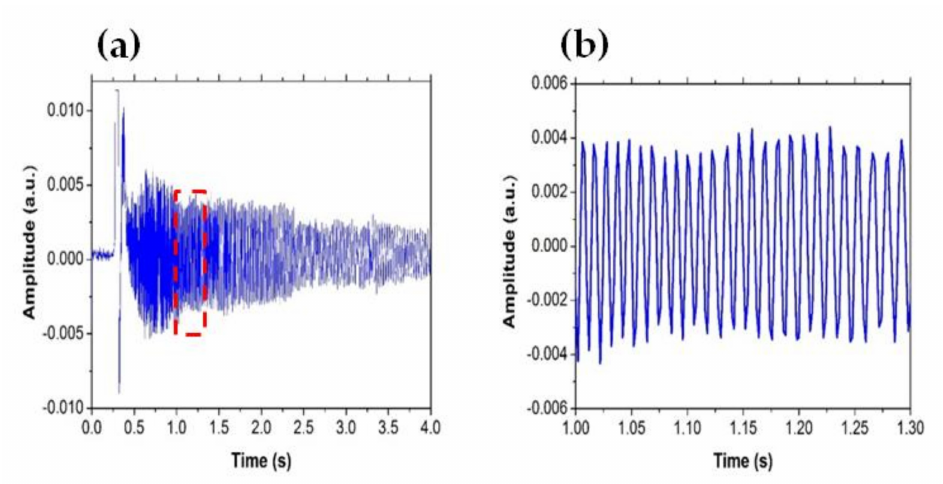
Figure 3. ( a ) Interference fringes visualized with the oscilloscope and ( b ) detail of the marked part of the interferogram.